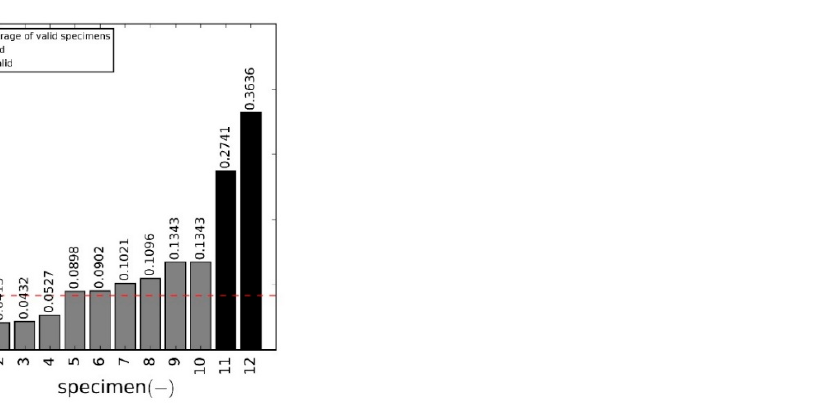
Figure 20. Electrical resistance of all the contacted specimens derived from potentiodynamic meas- urements.